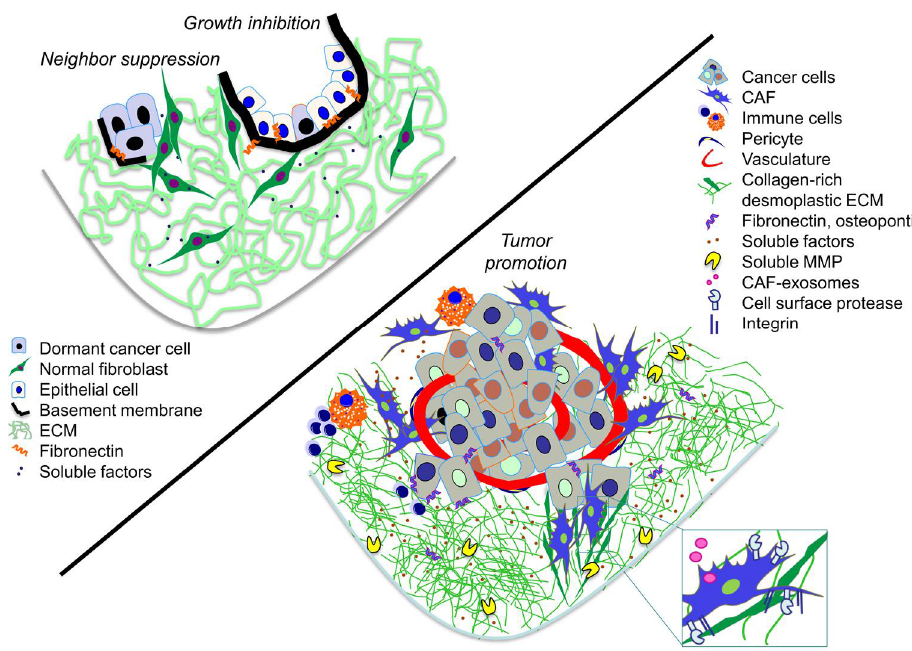
Figure 1. The dual action of fibroblast in the TME. Illustrative scheme showing the interactions and products of the anti-tumorigenic normal fibroblasts (upper-left) and the pro-tumorigenic cancer associated fibroblasts (CAFs) (lower-right).